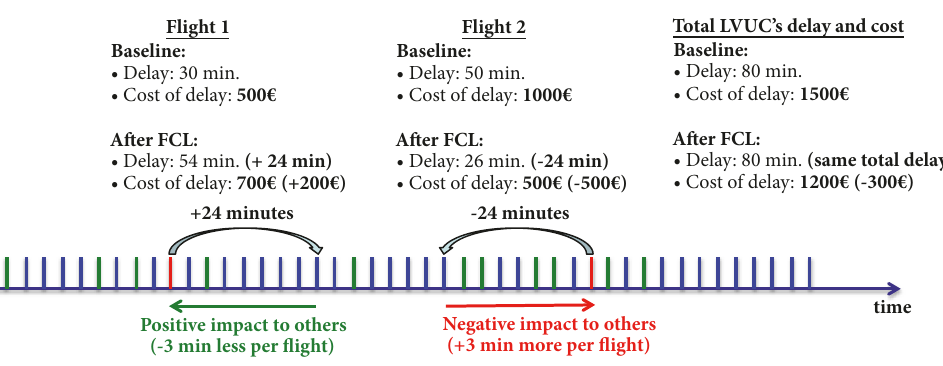
Figure 7: Illustration of an LVUC exchanging delay and credits in the same